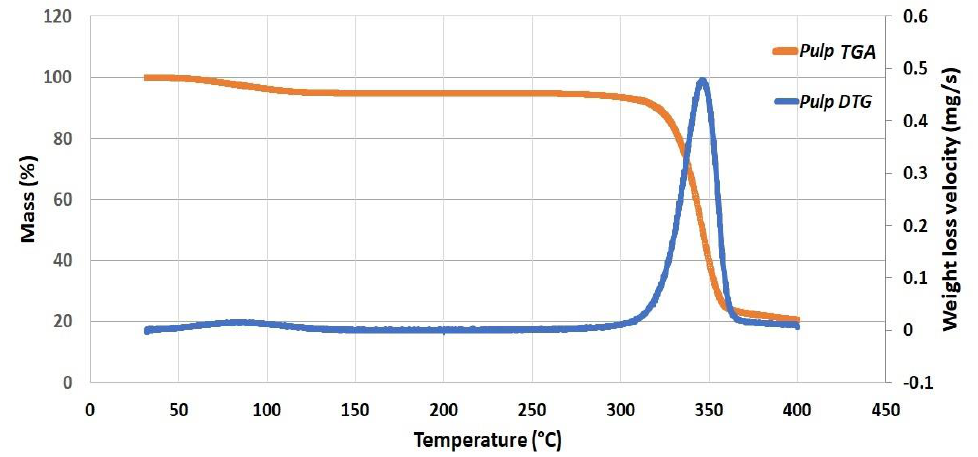
Figure 5. TGA curve, and DTG for the current cellulose pulp fibers.